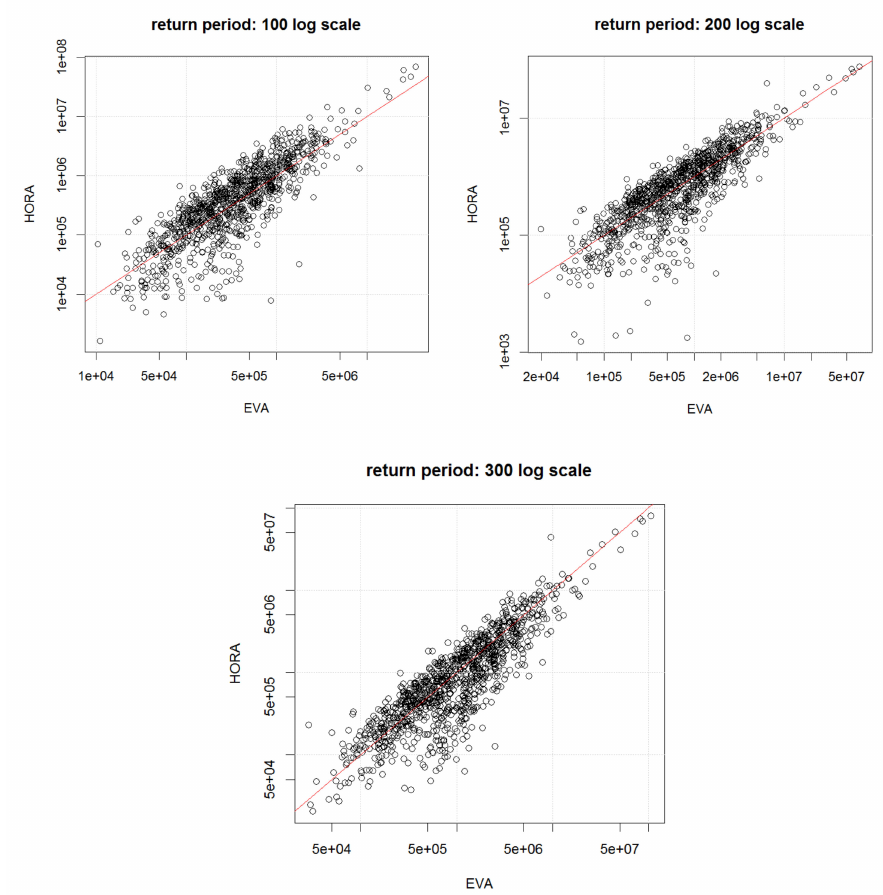
Figure A11. Scatterplot of the 100, 200, and 300-year return period level for all municipalities for the HORA method and the EVA method.